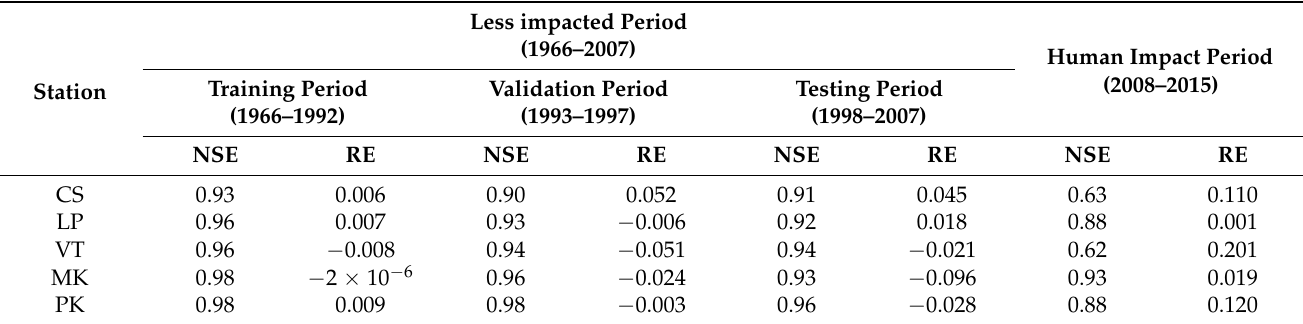
Table 2. Streamflow performance of HPD model for training, validation, testing, and human impact period.